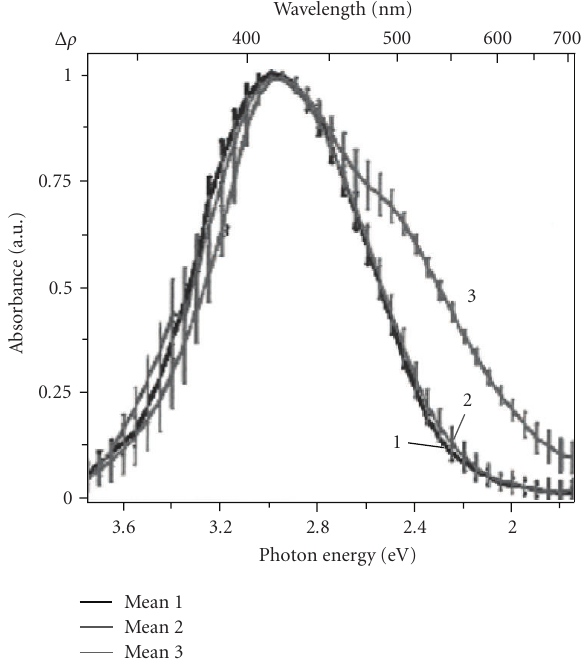
Figure 12: Average absorption spectra ( Δ ρ ) of various titania sys- tems. See text for details of the origins of these spectra. Reproduced with permission from [62]. Copyright (2006) American Chemical Society.